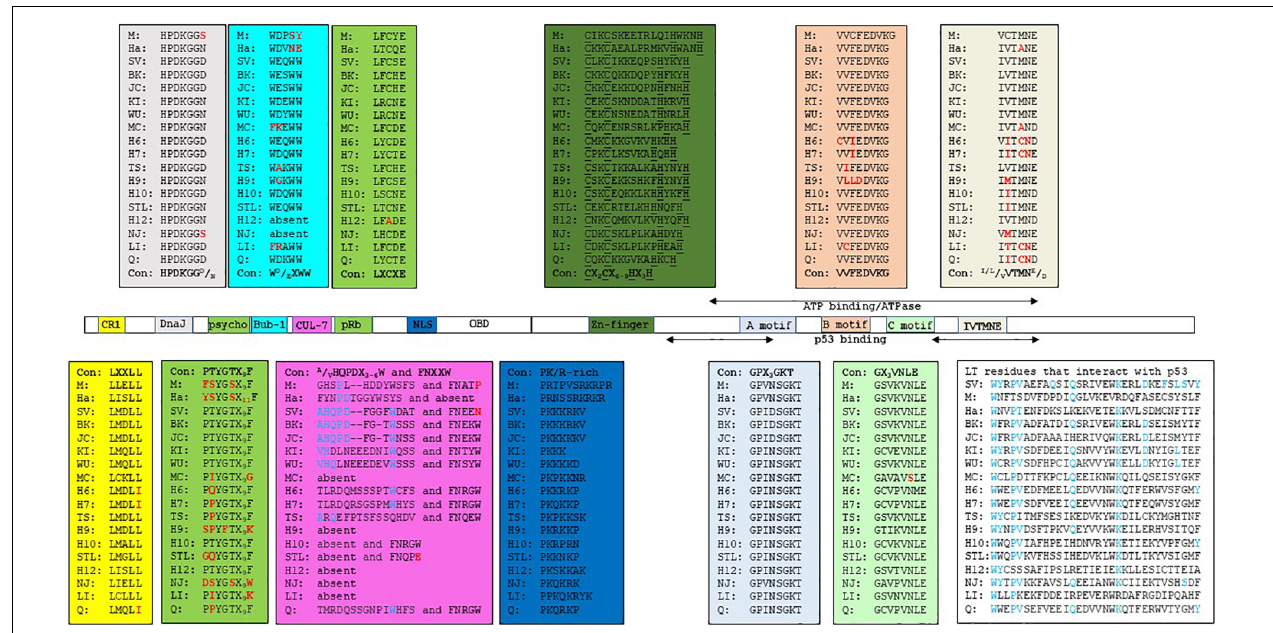
FIGURE 1 | Functional domains in the LT-ags of HPyVs. The amino acid sequence of the functional domains is given in the corresponding colored box. The consensus sequence (Con) for each domain is shown. M = MPyV (J02288), Ha = HaPyV (NC_001663), SV = SV40 (NC_001669), BK = BKPyV (NC_001538), JC = JCPyV (NC_001699), KI = KIPyV (NC_009238), WU = WUPyV (NC_009539), MC = MCPyV (NC_010277), H6 = HPyV6 (NC_014406), H7 = HPyV7 (NC_014407), TS = TSPyV (NC_014361), H9 = HPyV9 (NC_015150), H10 = HPyV10 (JX262162), STL = STLPyV (NC_020890), H12 = HPyV12 (NC_024118), NJ = NJPyV-2013 (NC_024118), LI = LIPyV (NC_034253), and Q = QPyV (BK010702. The accession number is given in parenthesis. CR1 = conserved region